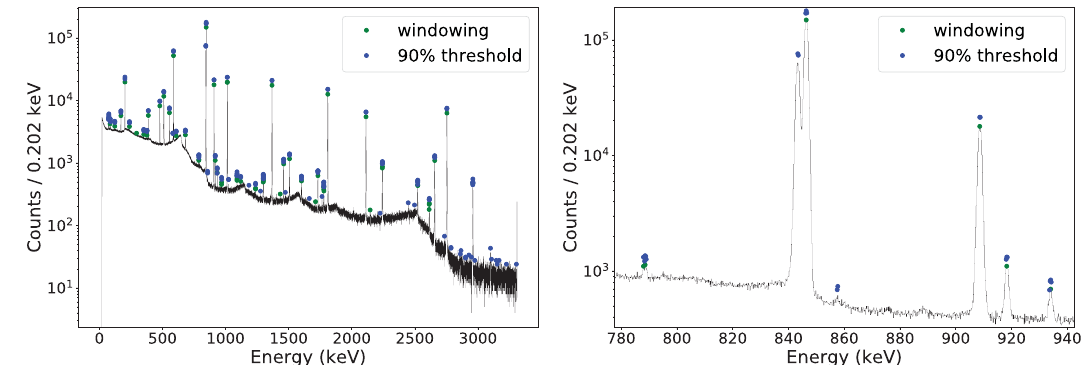
Figure 3: The recorded gamma spectrum for a Zr foil experiment at a count time of 64.5 s following an irradiation for 299 s. Peaks found with the conventional window method using